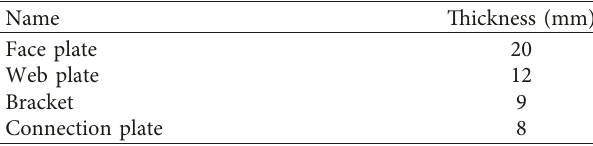
Figure 4: Structural parameters of steel foundation. Table 2: Thickness of each plate of the foundation.